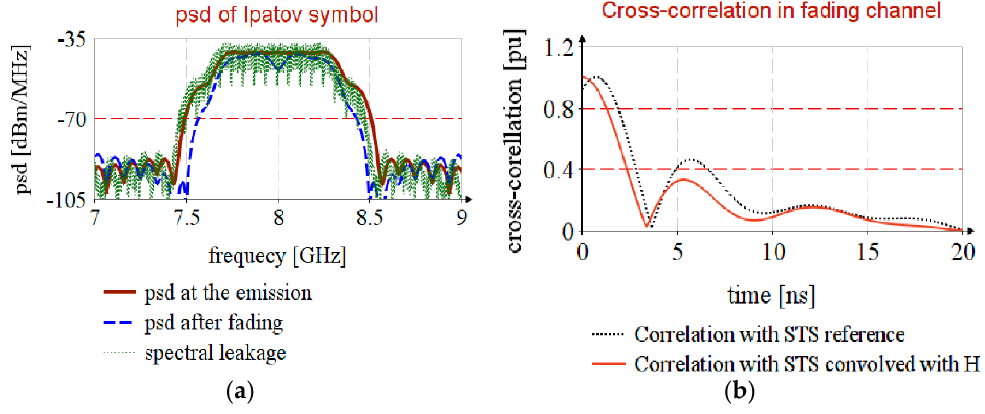
Figure 9. Timestamp estimation in channel with selective fading.